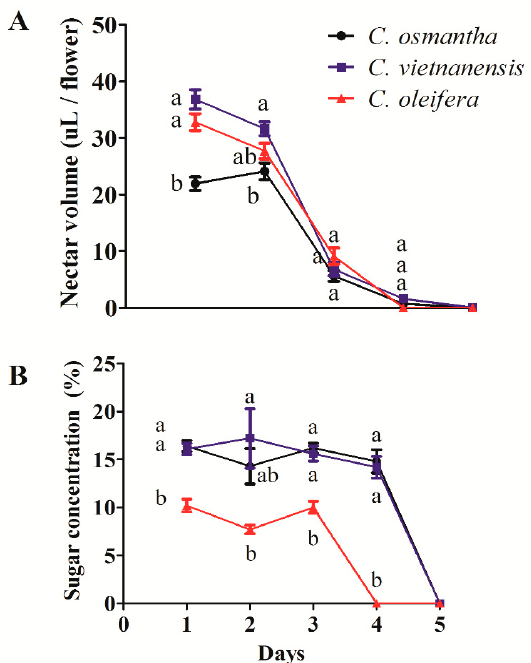
Figure 4. Nectar volumes ( A ) and sugar concentrations ( B ) of C. osmantha , C. vietnamensis , and C. oleifera . Values (mean ± S.E.) followed by different letters on the same day are significantly different based on Tukey’s HSD test at p < 0.05.